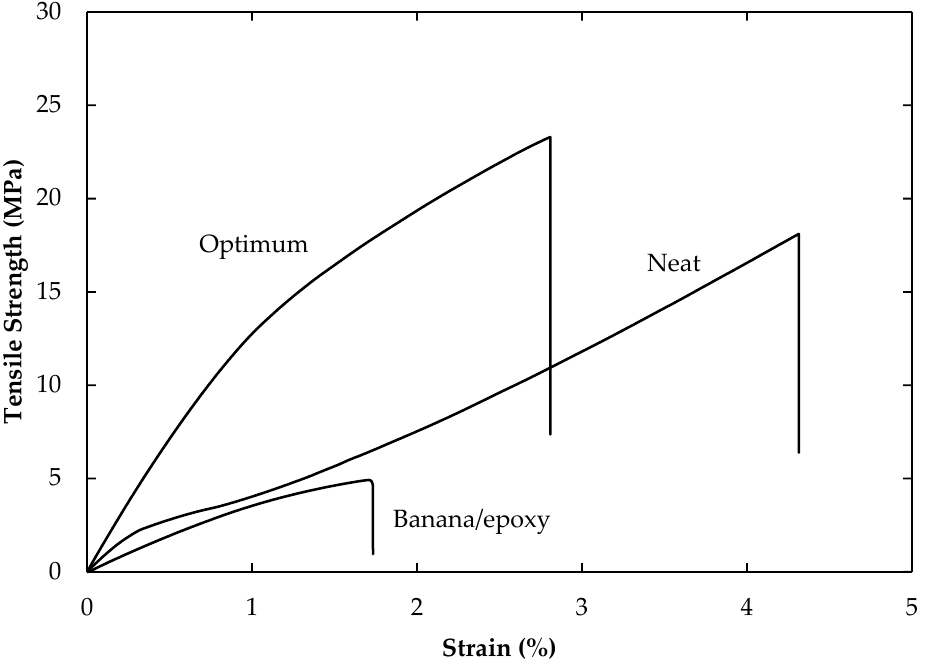
Figure4. Typicalstress–straincurveforneat,optimalbanana / epoxycomposite,andbanana / epoxycomposite. Figure 4. Typical stress–strain curve for neat, optimal banana/epoxy composite, and banana/epoxy composite.